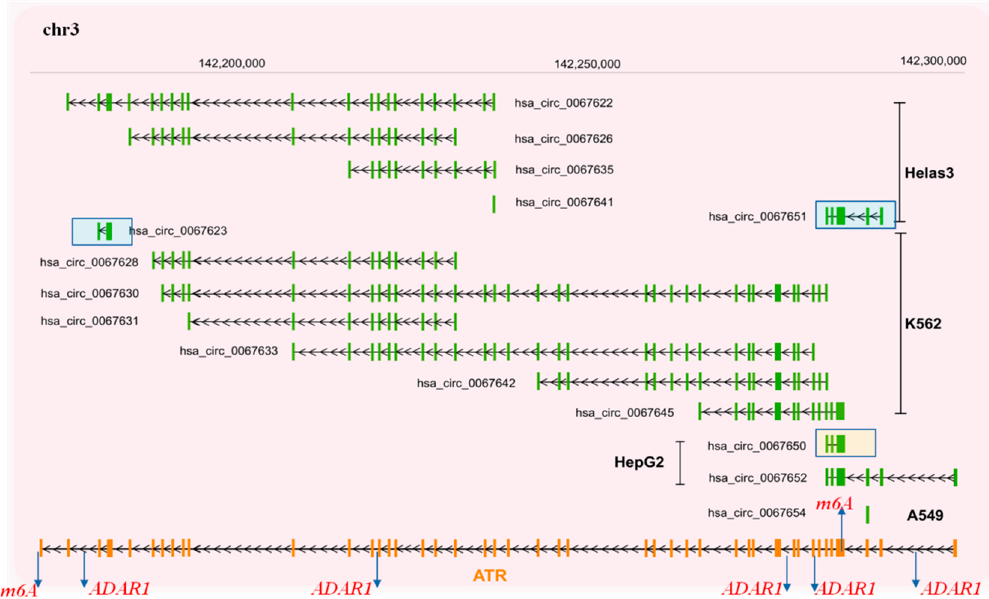
Figure 5. Potential circRNAs derived from the ATR gene locus. Predicted circRNAs at the ATR gene locus, based on NGS data, as deposited at circBase and CIRCpedia are shown over the corresponding loci, based on human genome GRCh37/hg19. Cell lines in which NGS was performed to obtain the depicted circRNAs are also shown and were retrieved from circBase. For more details, see Supplementary Figures. Furthermore, we indicate from miCLiP experiments [91] a